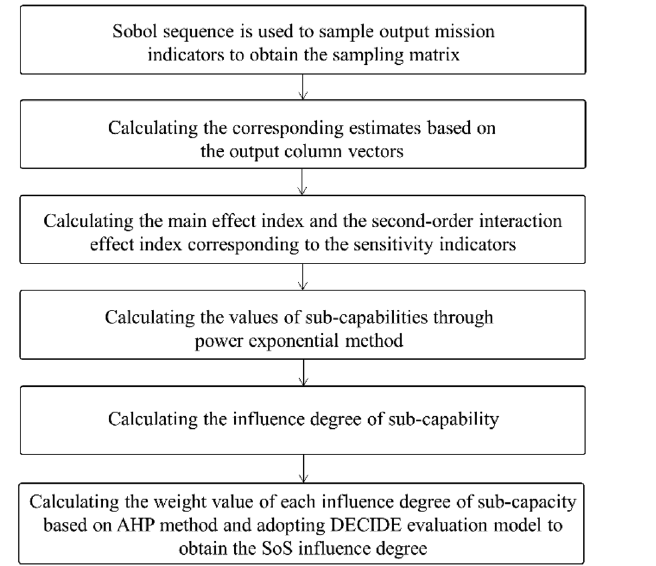
Figure 2. Flow diagram of the SPS analysis